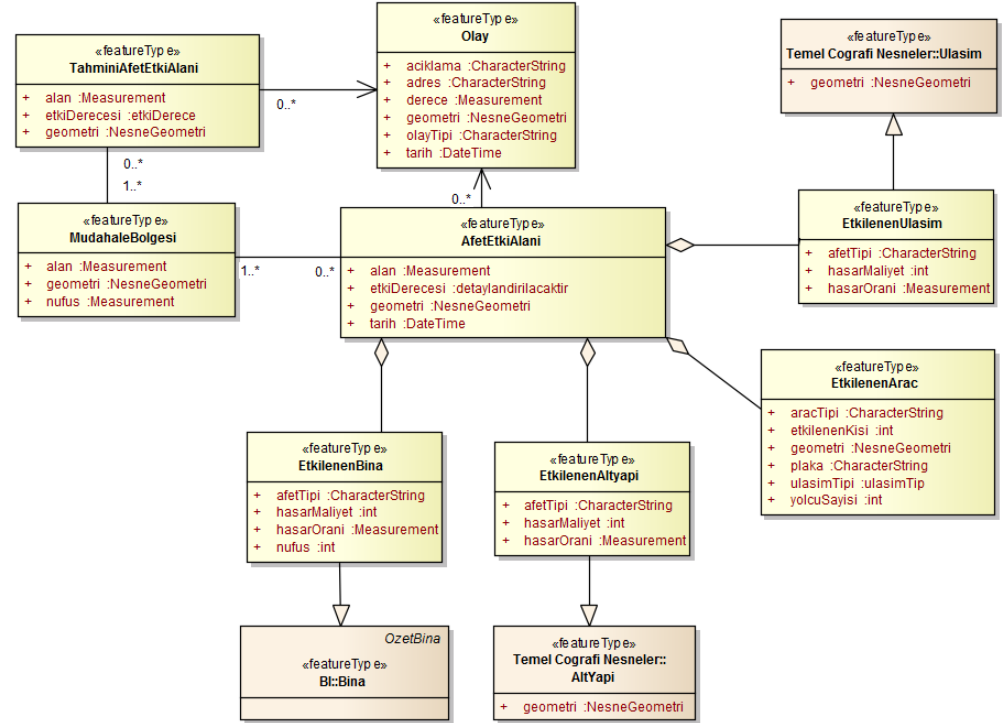
Figure 5. ADYS feature types concerning disaster effect